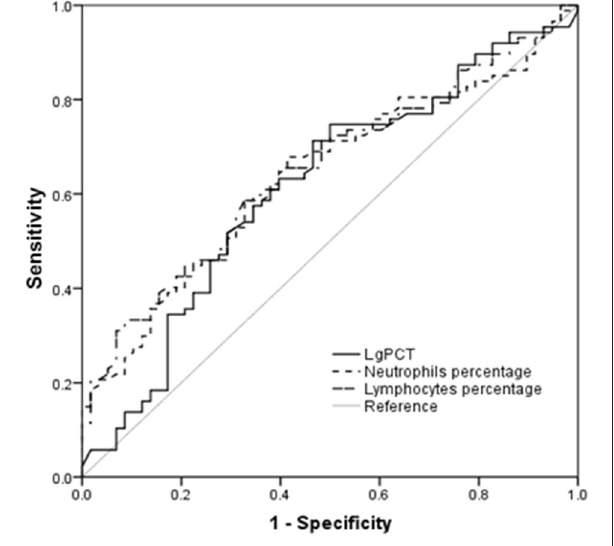
FIGURE 2 | Procalcitonin (PCT) and the percentages of neutrophils and lymphocytes in predicting secondary bacterial infection in hemorrhagic fever with renal syndrome (HFRS) patients by receiver operating characteristic curve (ROC) analysis.